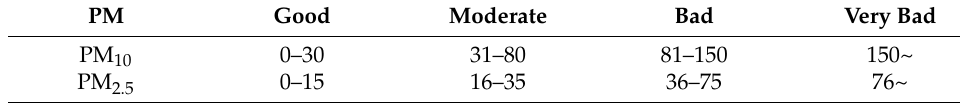
Table 4. The results of discriminant for movement of particulate matter by wind direction.